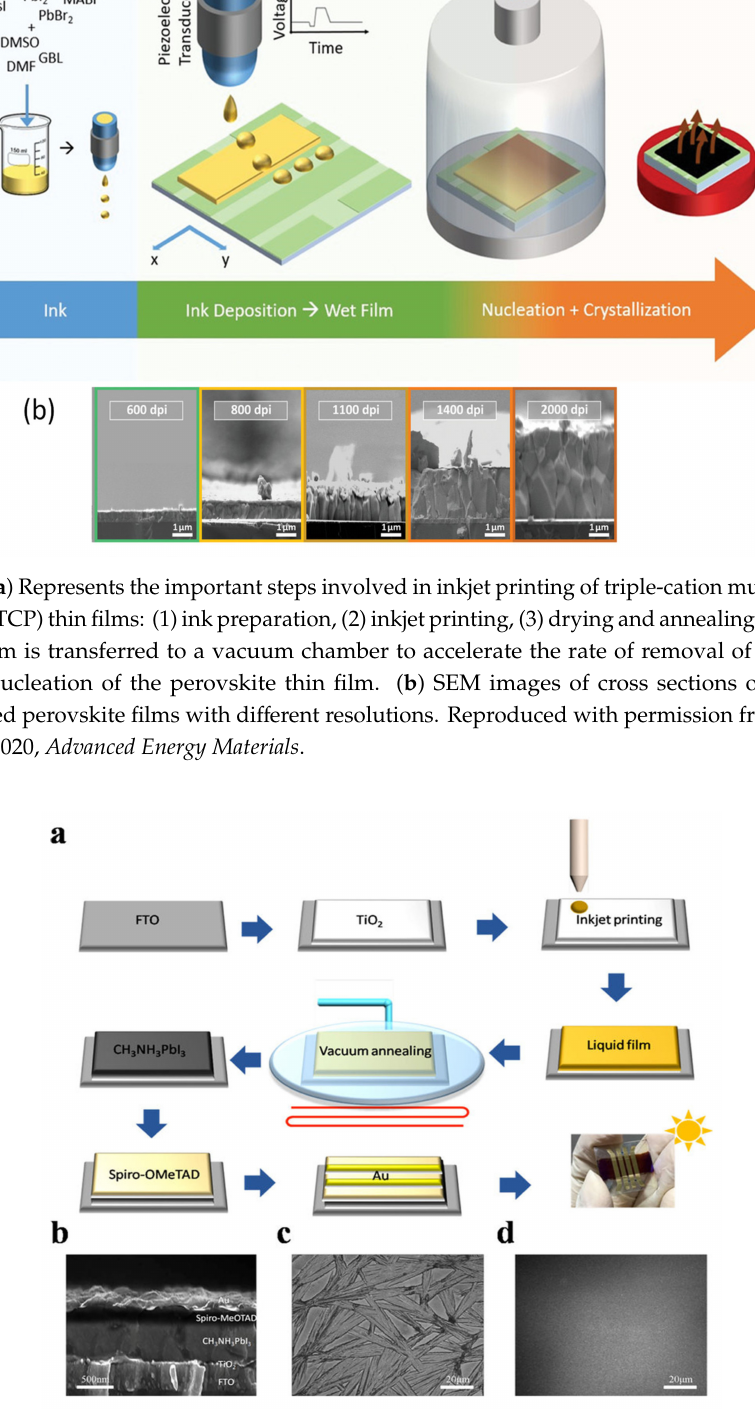
Figure 13. ( a ) Represents the fabrication of PSC through inkjet printing. ( b ) Cross-sectional SEM of a complete photovoltaic device. ( c , d ) The optical images of inkjet-printed MAPbI 3 thin film by conventional annealing and vacuum-assisted thermal annealing. Reproduced with permission from ref. [176], Copyright 2018, Solar RRL